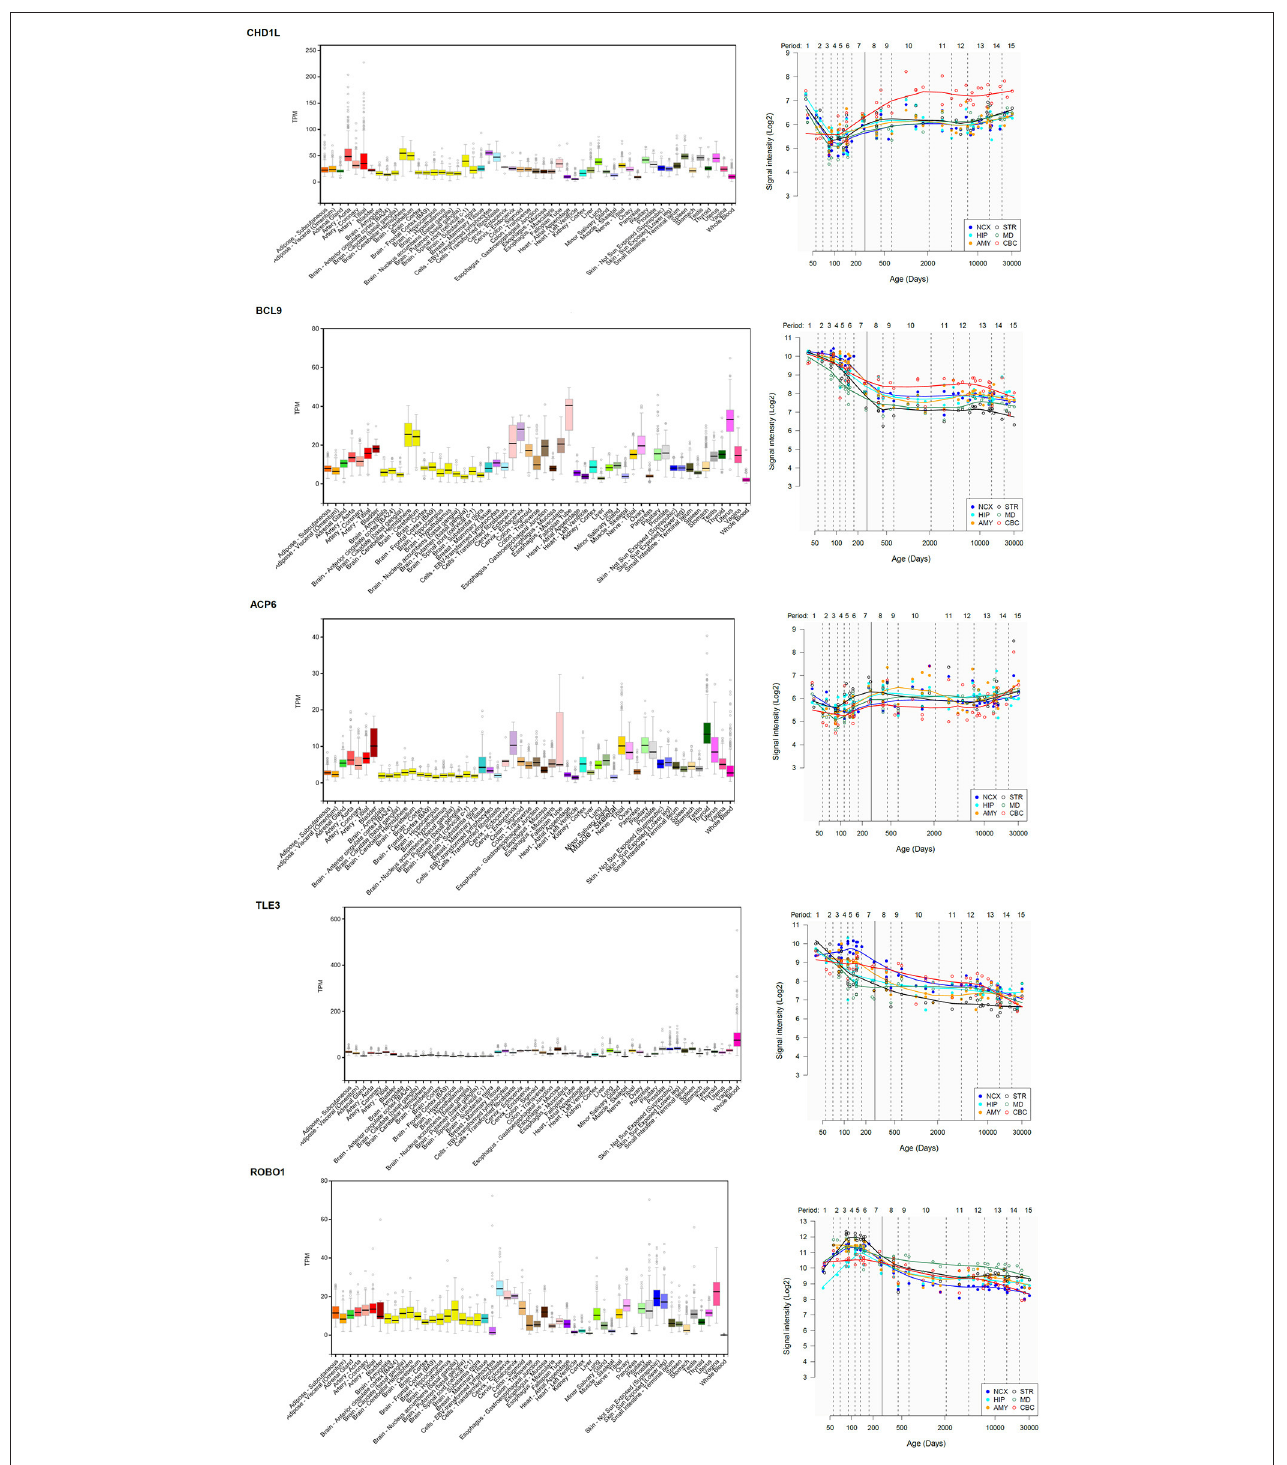
FIGURE 7 | Expression pattern in the body and the brain of genes of interest in the proband. (Left) Expression levels of the gene in different tissues according to the Genotype-Tissue Expression (GTEx) project (44). Statistical analysis and data interpretation was performed by The GTEx Consortium Analysis Working Group. Data was provided by the GTEx LDACC at The Broad Institute of MIT and Harvard. TPM, transcripts per million. (Right) Brain expression profile of the gene across development. The expression data are from the Human Brain Transcriptome Database (http://hbatlas.org/). Six different brain regions are considered: the cerebellar cortex (CBC), the mediodorsal nucleus of the thalamus (MD), the striatum (STR), the amygdala (AMY), the hippocampus (HIP), and 11 areas of neocortex (NCX).